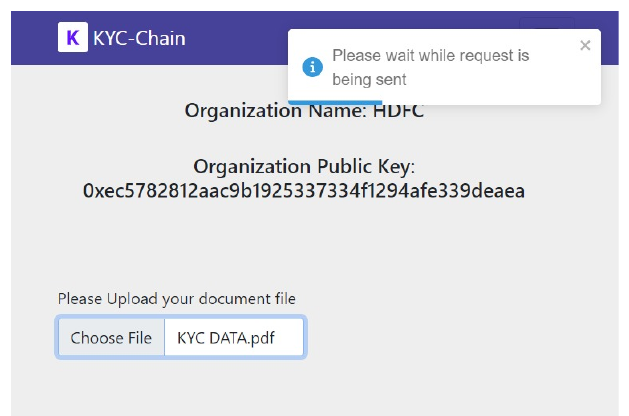
Fig. 6. Addition request initiated by user